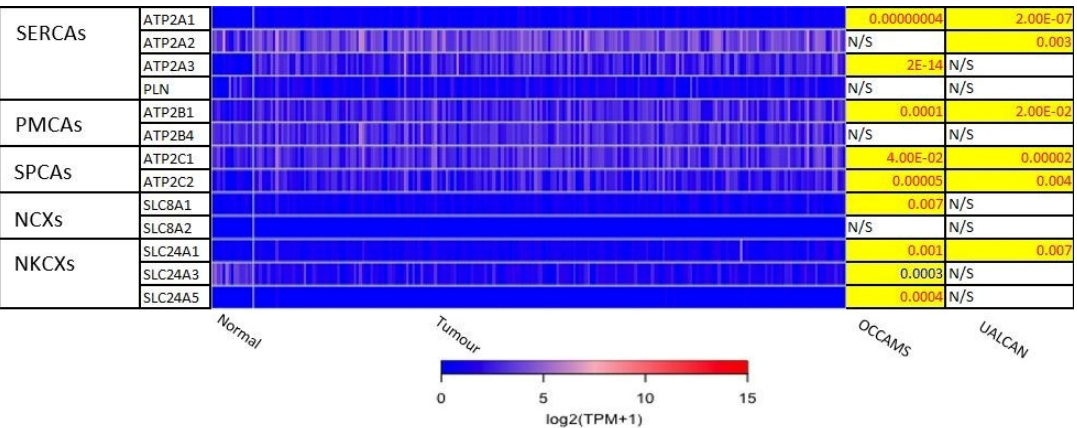
Figure 3. Expression of Ca 2+ pumps and exchangers in OAC. Please see Figure 2 for details. NCXs: Na + /Ca 2+ exchangers; NKCXs: sodium potassium calcium exchangers; ATP2A: sarco-endoplasmic-reticulum Ca 2+ ATPase; PLN: phospholamban;